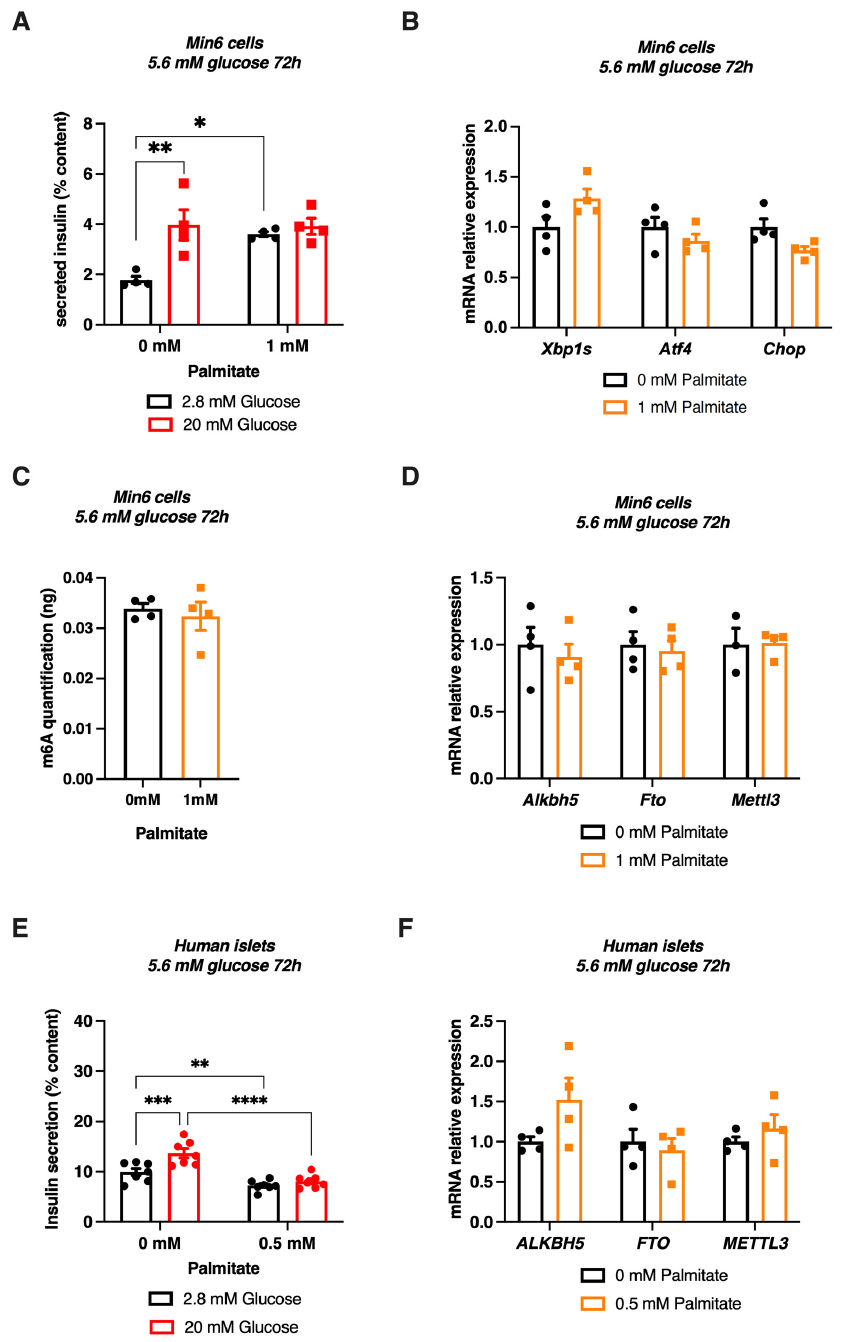
Figure 5. Effects of a chronic low glucose and palmitate treatment on m 6 A RNA methylation and m 6 A enzyme expression in Min6 cells and non-diabetic human islets. ( A , B ) Glucose-stimulated insulin secretion was quantified by ELISA (( A ), n = 4) and quantification of mRNA expression